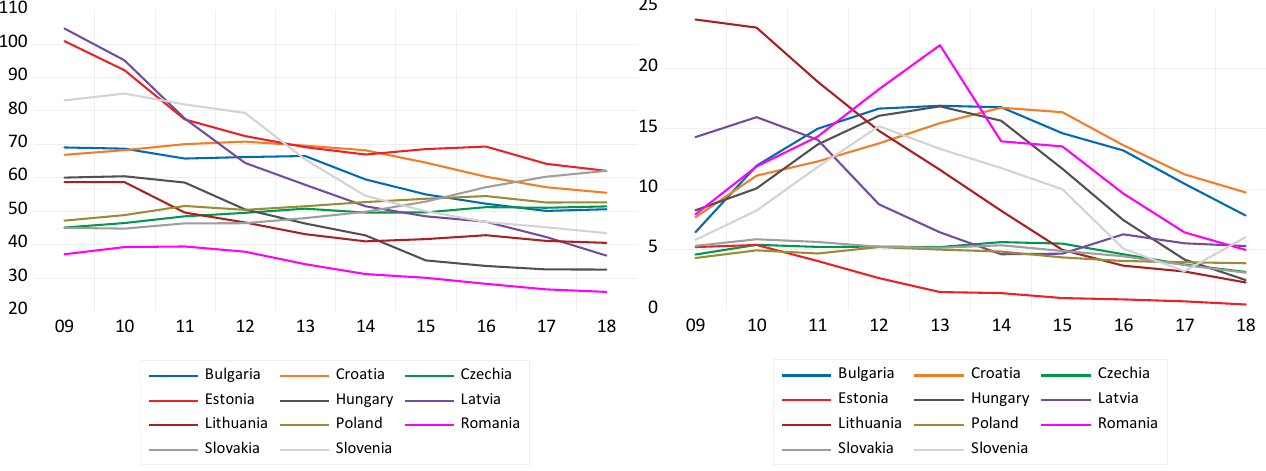
Figure 5. Domestic credit to the private sector-% ( left panel) and non-performing loans-% ( right panel) in CEE countries, 1995–2018 (%).